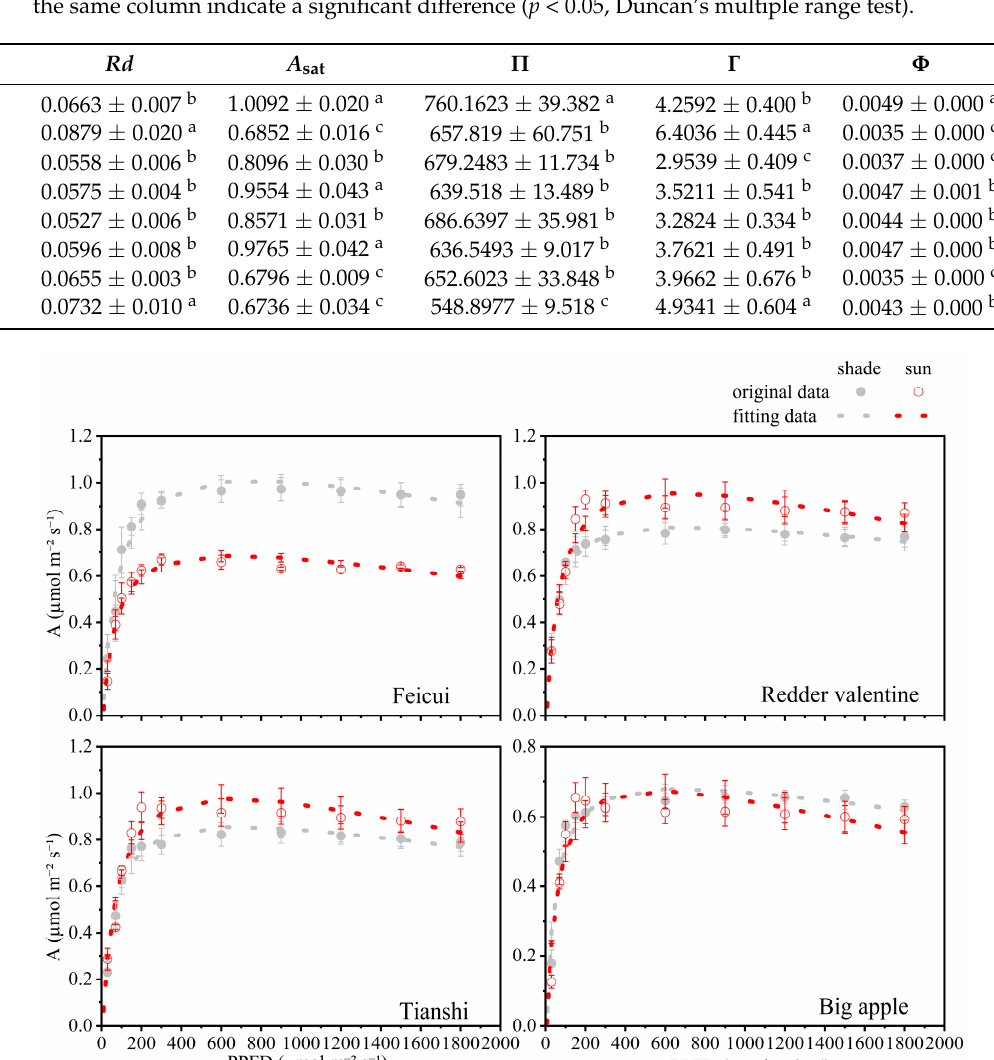
Figure 3. Net photosynthetic rate versus incident photosynthetic photon flux density (PPFD) of four cultivars of A. commutatum for shade original data (gray solid points), original sun data (red solid points), shade fitting data (gray dot lines), sun fitting data (red dot lines). Corresponding light re- sponse parameters are given in Table 1. Table 1. Photosynthetic light response parameters of leaves of Feicui, Redder valentine, Tianshi, and Big apple grown in sun or shade. Data represent the mean ± SD (n = 3). Different lowercase letters in the same column indicate a significant difference ( p < 0.05, Duncan’s multiple range test).